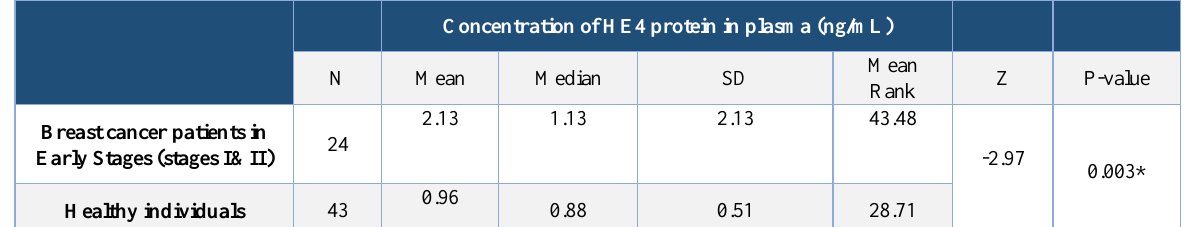
Table 4. Levels of HE4 in plasma samples from BC patients in early stages and healthy individuals. Mean plasma HE4 values for BC patients in early stages was significantly higher by 1.16 ng/mL and standard error of 0.44 compared with healthy